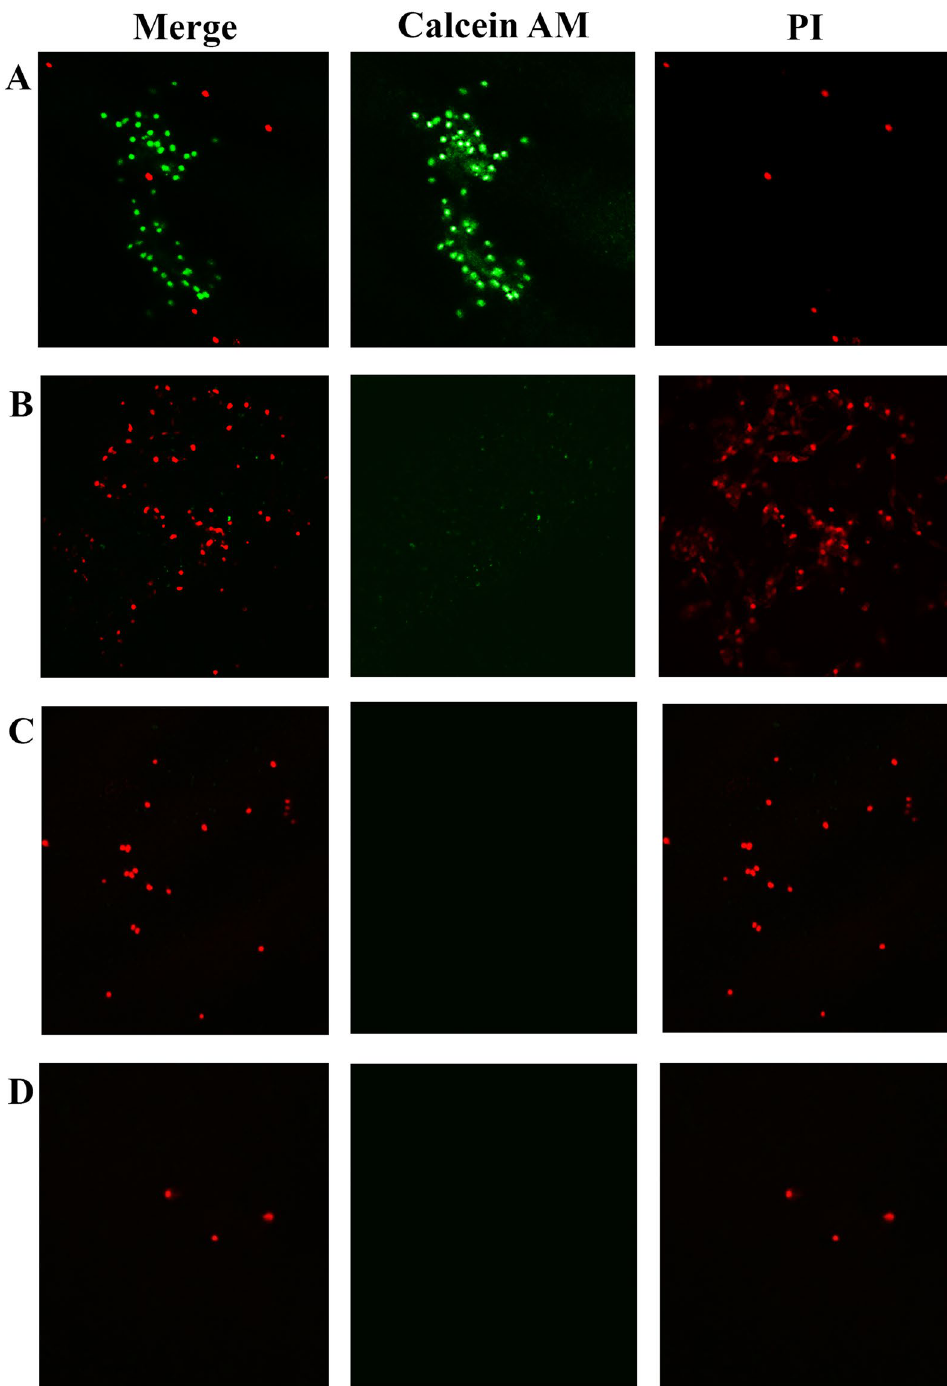
Figure 3. Calcein-AM/PI live/dead staining of the maternal cells on the VM. ( A ) Maternal cells on the VM at the D1 storage time ( × 200). ( B ) Maternal cells on the VM at the D7 storage time ( × 200). ( C ) Maternal cells on the VM at the D14 storage time ( × 200). ( D ) Maternal cells on the VM at the D21 storage time ( × 200). The live cells were stained green, and the dead cells were stained